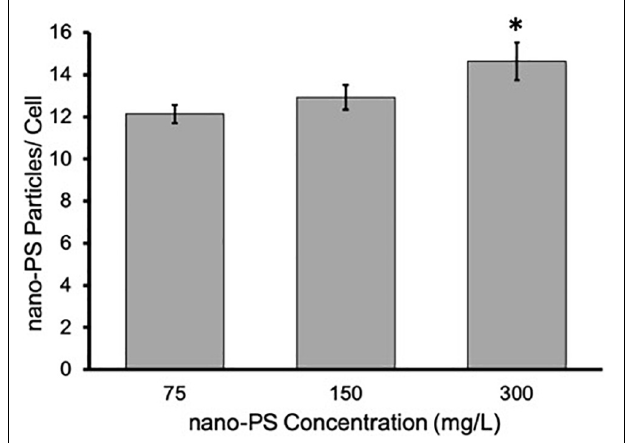
FIGURE 6 | Comparison of the number of nano-PS normalized to the number of cells for samples exposed to 75, 150, and 300 mg/L nano-PS in anaerobic conditions for 12 h. A significant increase ( ∗ p < 0.05) in the number of nano-PS particles/cell for samples exposed to 300 mg/L nano-PS was observed in comparison to bacteria exposed to 75 and 150 mg/L nano-PS. Error bars represent SEM of biological triplicates.